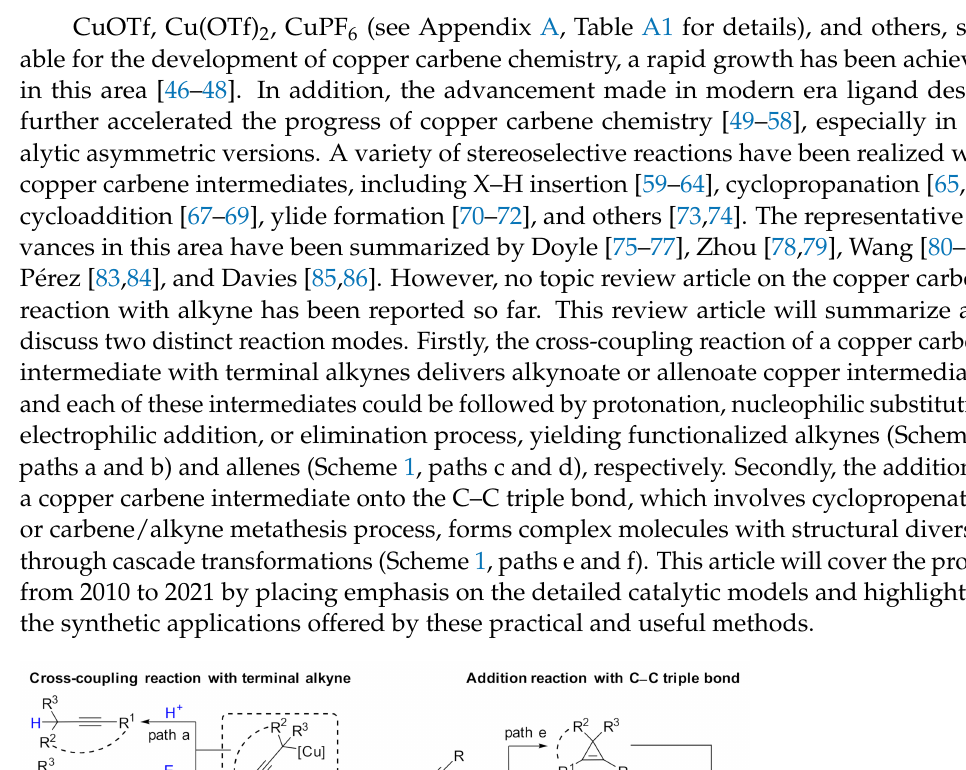
Figure 1. Collected publications and citations report of copper carbene from Web of Science